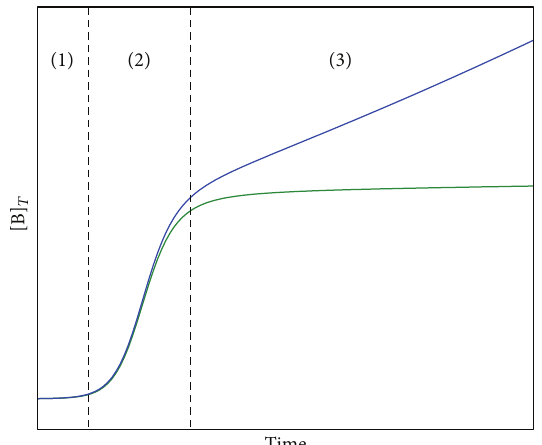
Figure 1: Sketch of typical SA/V-dependent EPEC growth curves ( [ B ] 𝑇 = total bacteria concentration): (1) lag phase and (2) expo- nential growth independent of the SA/V and (3) later stage growth depending on the SA/V. If the SA/V increases also the rate of the later stage growth increases. Note that under common laboratory culturing conditions the SA/V remains relatively small so that the later stage growth may look stationary (green curve) which, however, does not appear to be the case at higher SA/V ratios (blue